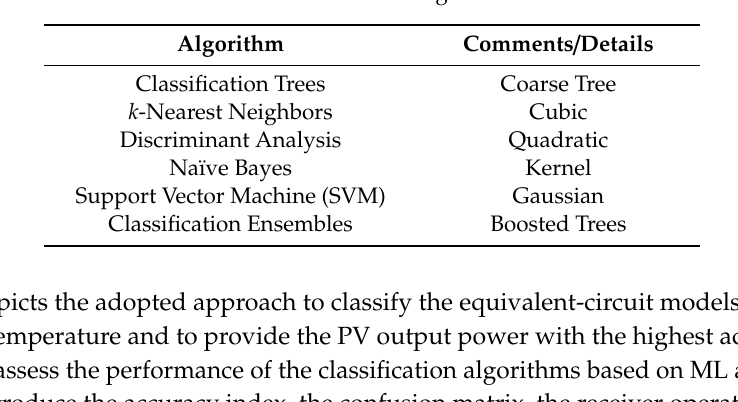
Table 1. Machine learning